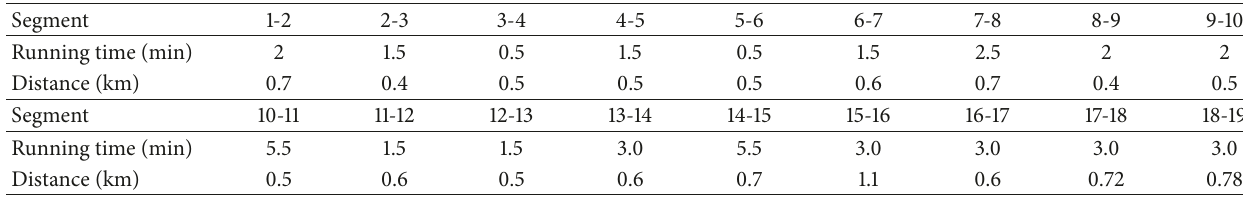
Table 2: Running time and distance between successive